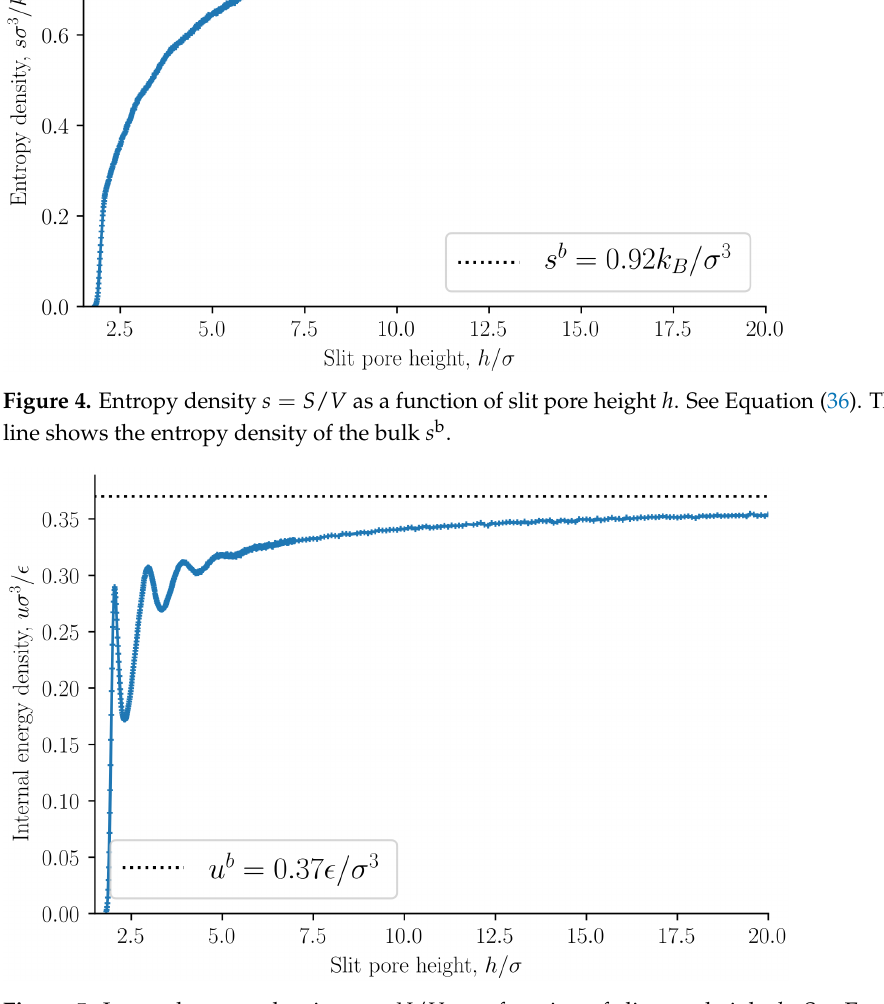
Figure 5. Internal energy density u = U / V as a function of slit pore height h . See Equation (35). The dashed line shows the internal energy density of the bulk u b